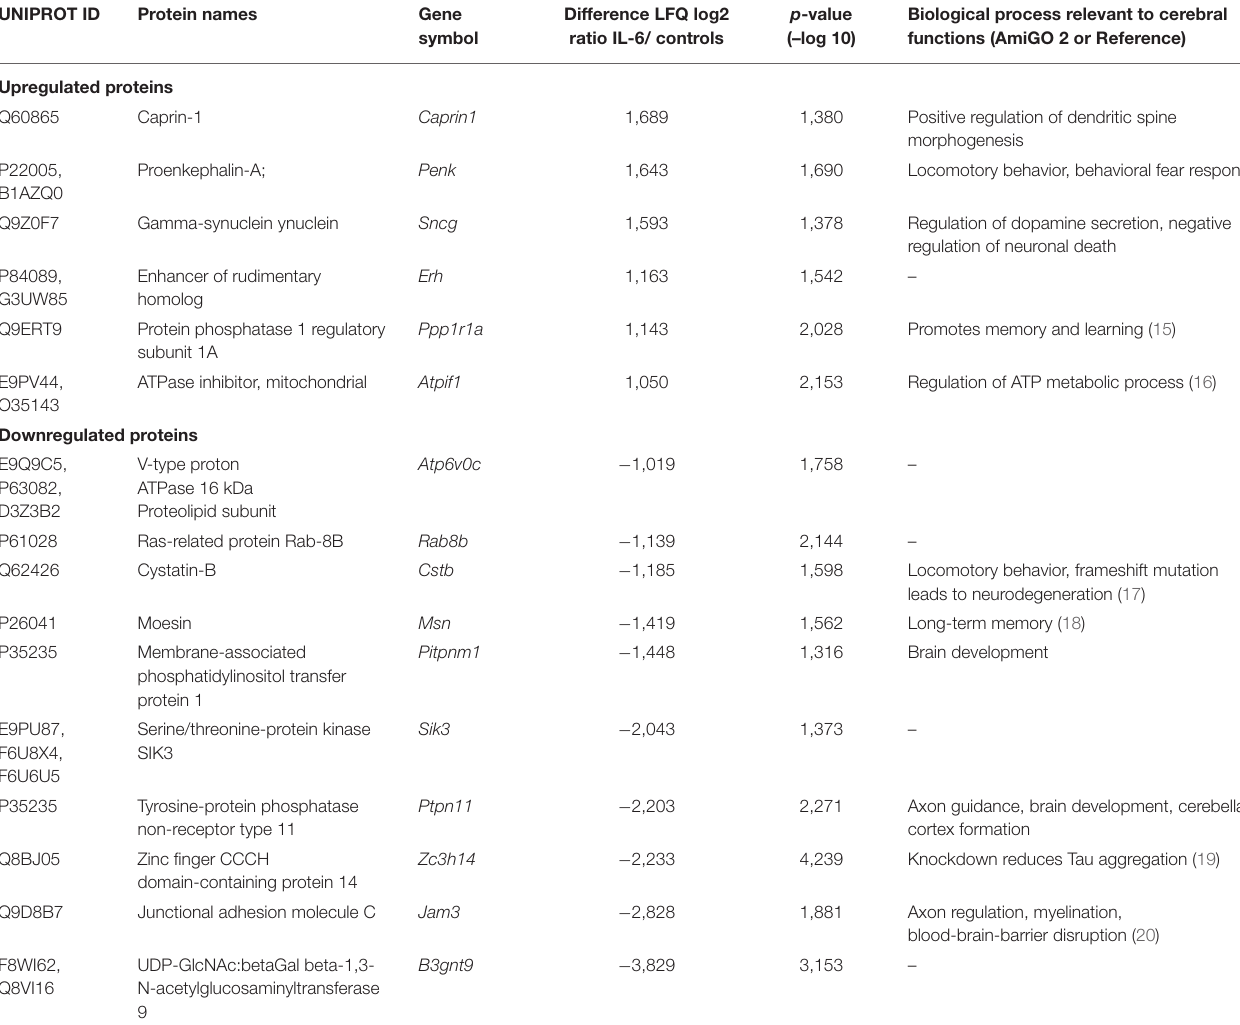
* Up- and down-regulated proteins in striatal corticospinal tract samples ipsilateral to the CCAo. The proteins are sorted by their expression change indicated by the difference of the LFQ log2 ratio between IL-6 animals and controls. Significance is indicated by a log10 p-value.